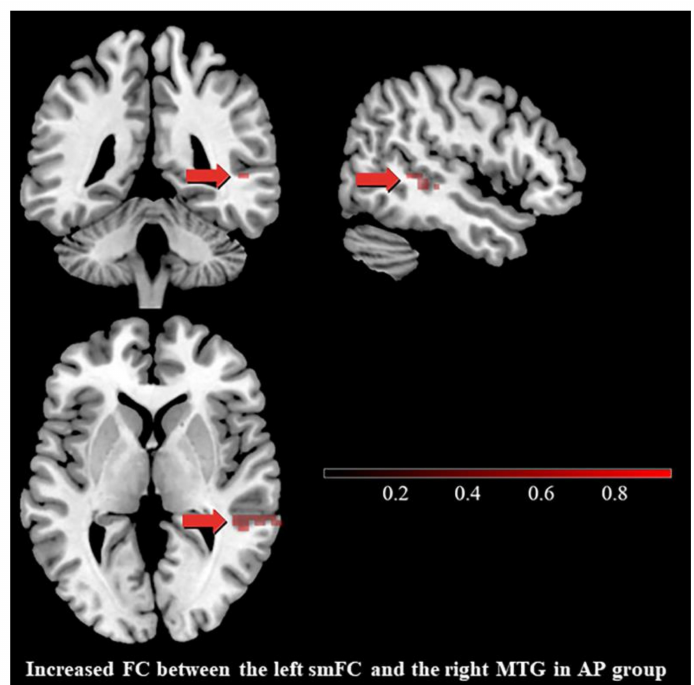
Figure 4. In the DMN, differences in FC between groups between the left smFC and the right MTG. The red arrow shows the corresponding brain region. The positive value (red) means OP < AP at a threshold of p < 0.001, GRF-corrected.